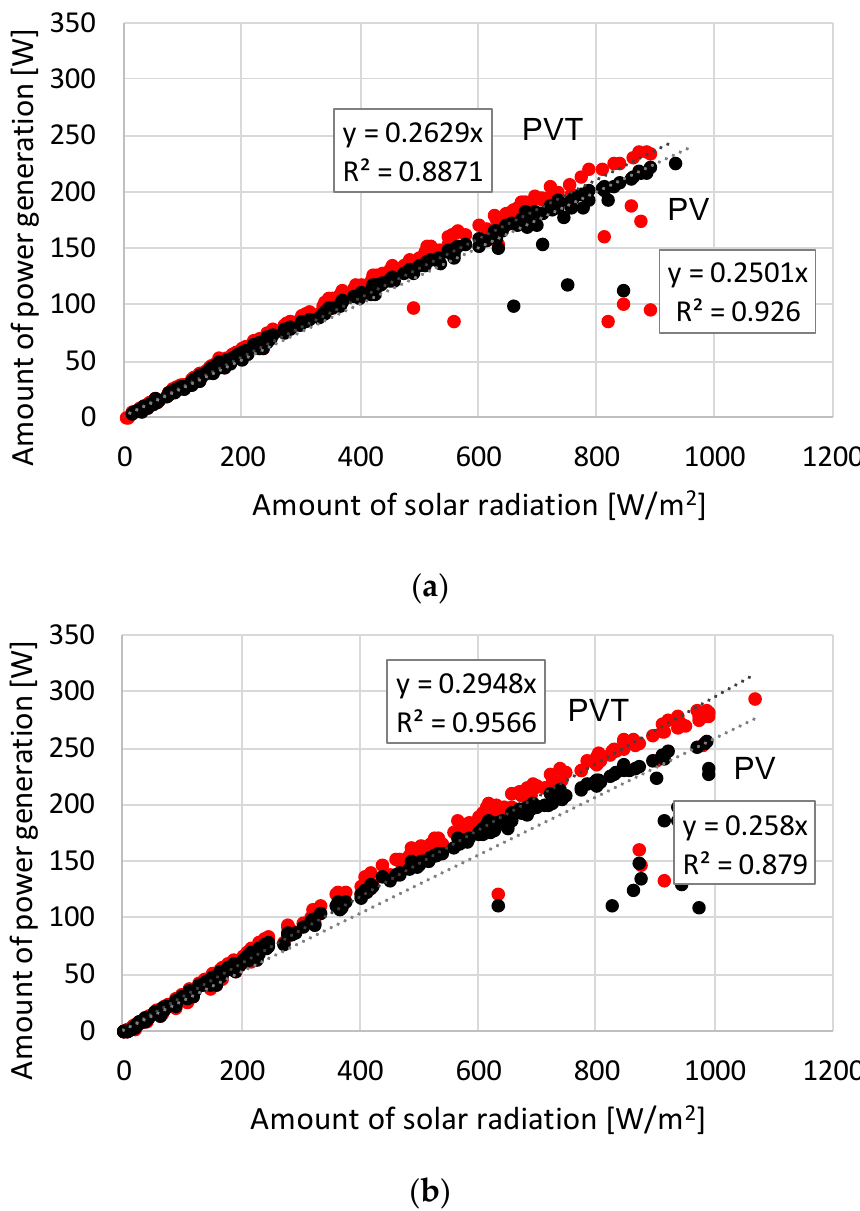
Figure 9. Relationship between insolation and power generation: ( a ) summer; ( b ) winter.